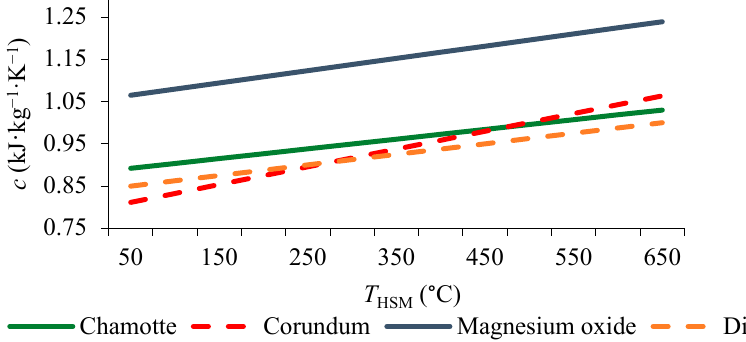
Figure 4. Dependence of heat capacity ratio on temperature T HSM